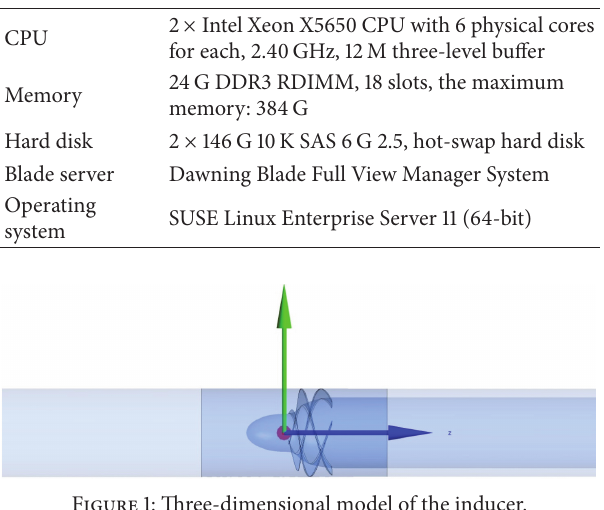
Figure 2: Unstructured mesh for the inducer.